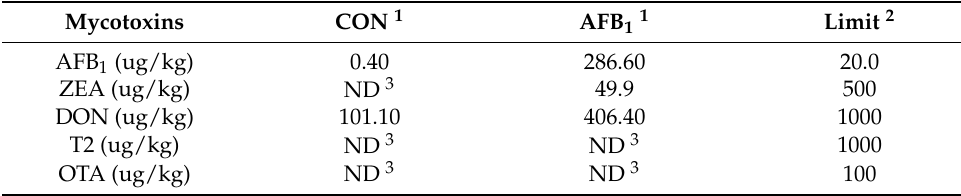
Table 1. The concentration of mycotoxin in